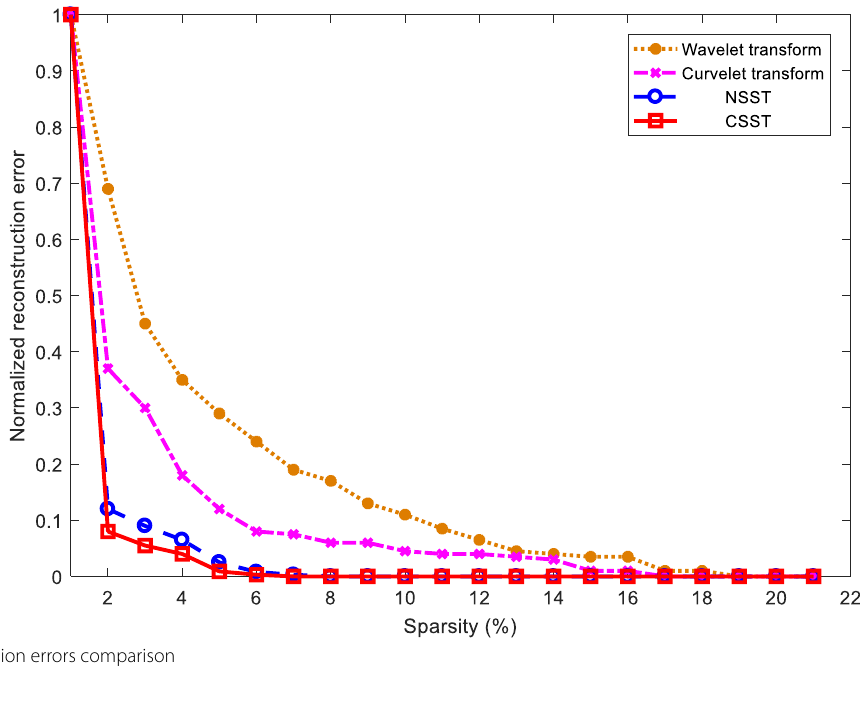
Fig. 3 Reconstruction errors comparison